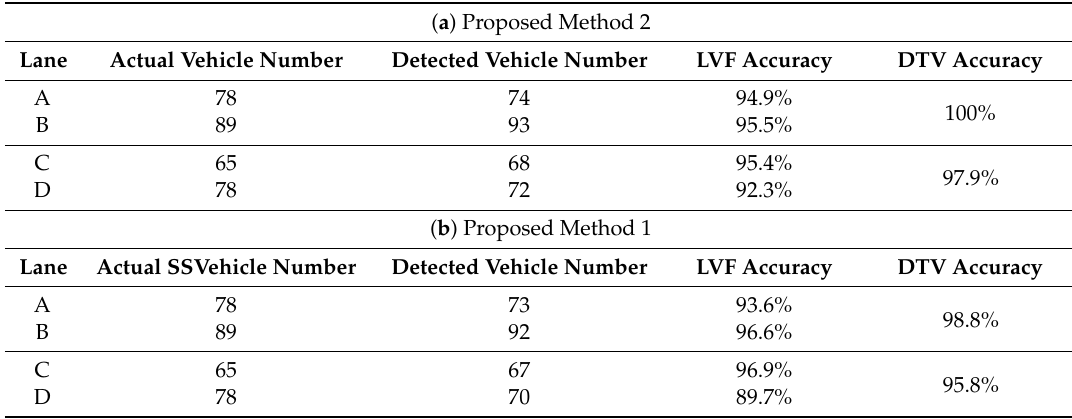
Table 12. Results of LVF and DTV detection during 8:10–8:20 PM (rush-hour traffic) using ( a ) proposed method 2 and ( b ) proposed method